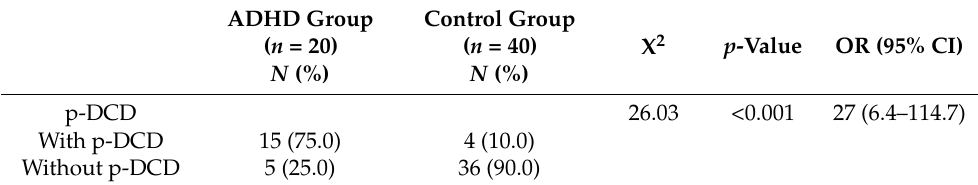
Table 1. Prevalence of p-DCD in ADHD and control groups ( n =